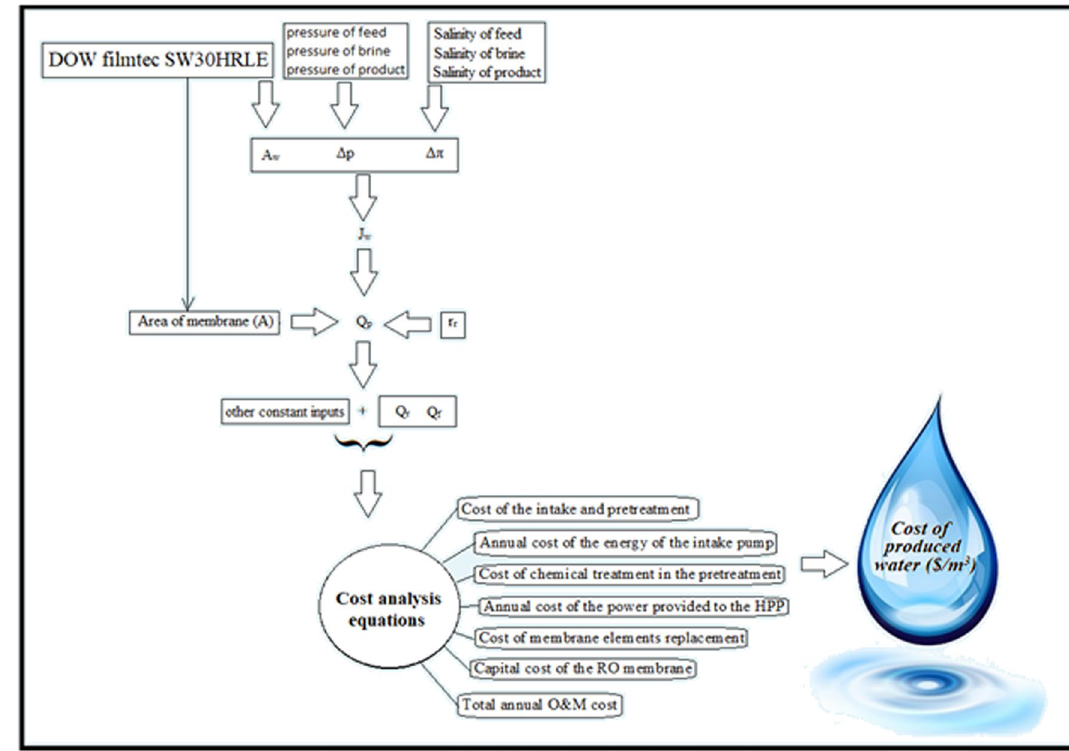
Fig.3 Calculating algorithm for comparative cost